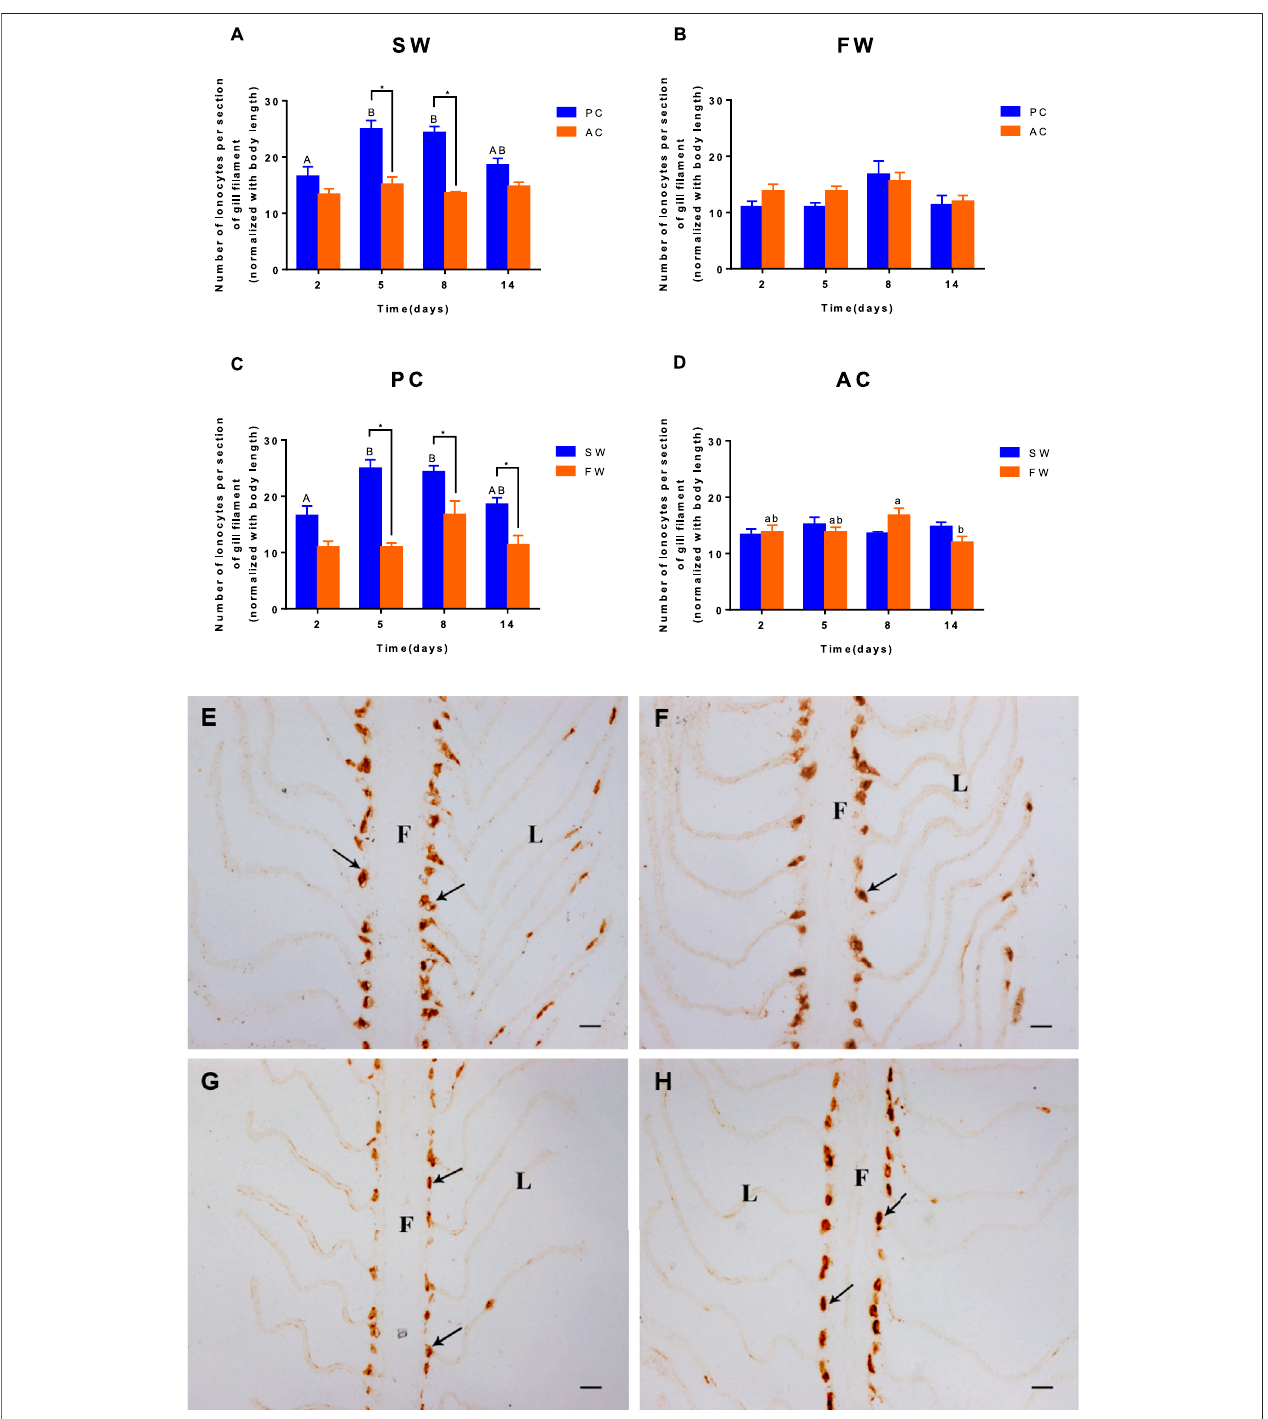
FIGURE 3 | The number of ionocytes per section of gill from olive fl ounder with passive coping style [PC, (C) ] and active coping style [AC, (D) ] after transfer from seawater[SW, (A) ]tofreshwater[FW, (B) ].Fiveadjacentlamellasweresetasonesection.Eachgillofa fi shchose fi vesections.Dataaremean±SEM( n =6).Anasterisk signi fi esasigni fi cantdifferencebetweenthePCandACgroupsateachtimepoint( p < 0.05).Differentlettersdenoteasigni fi cantdifferenceacrosstimewithineachPCor ACgroup( p < 0.05).Theimmunocytochemistryforionocytesingillsfromolive fl ounderwithpassivecopingstyle[PC, (E,G) ]andactivecopingstyle[AC, (F,H) ]from seawater [SW, (E,F) ] to freshwater [FW, (G,H) ] for 5 days. Scope time (×200). F, fi lament; L, lamella; black arrow, and ionocytes. Bar = 20 μ m.